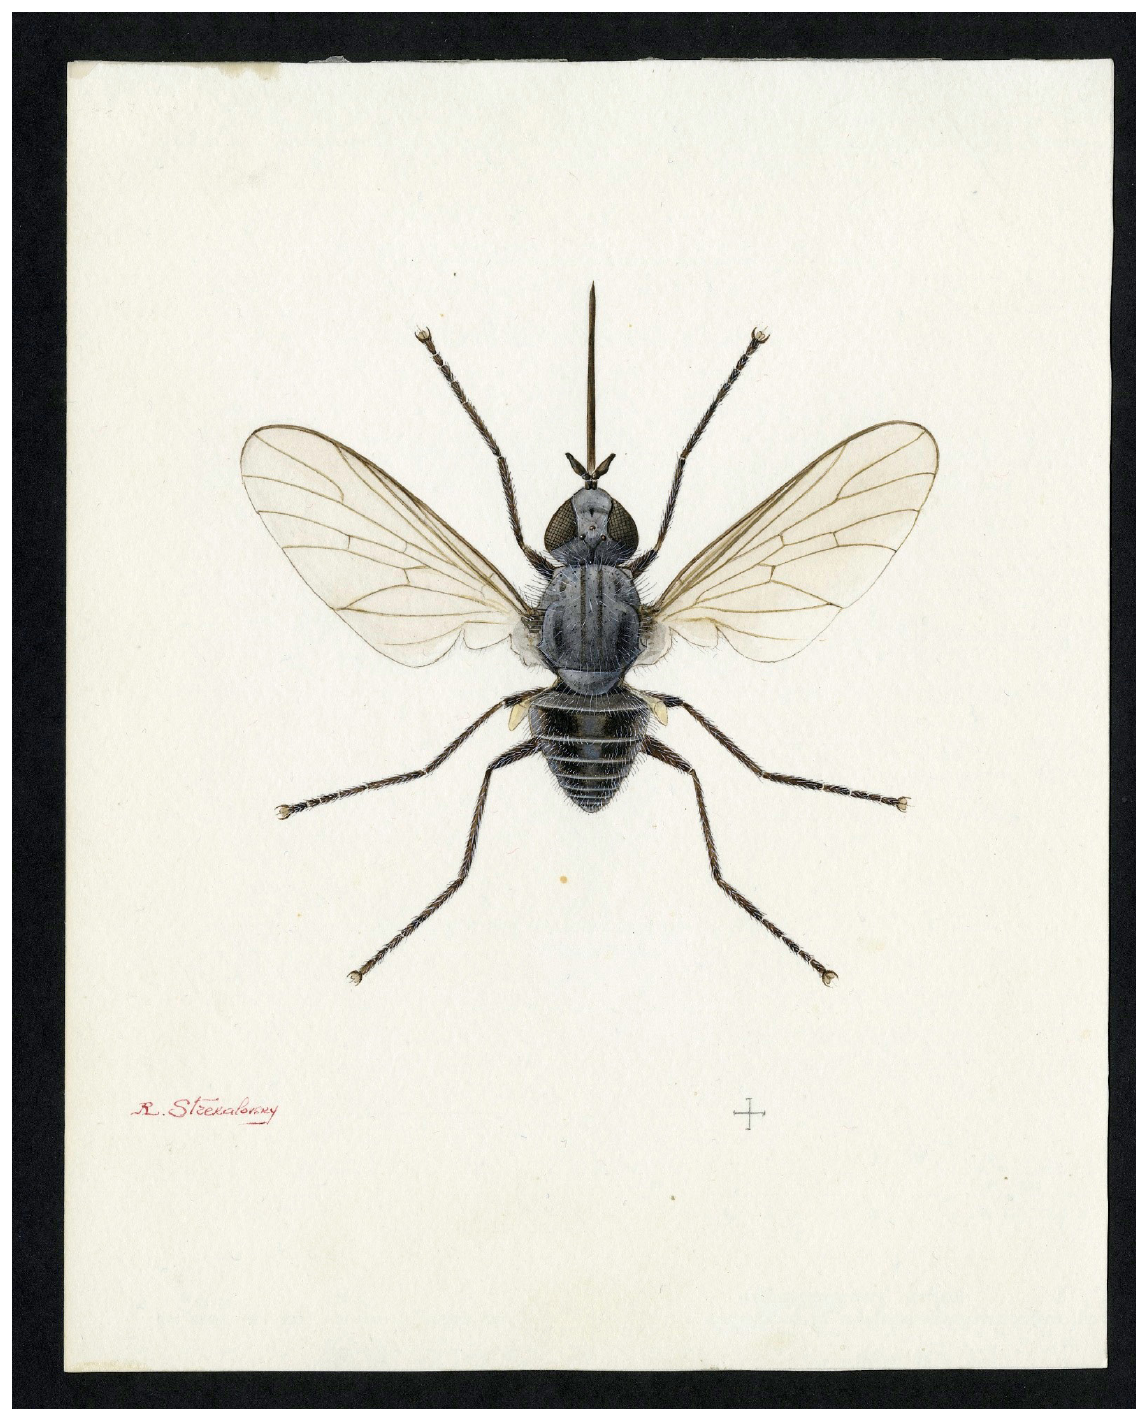
Fig. 57. Protypusia tewfiki (Efflatoun, 1945) gen. et comb. nov., habitus, Smithsonian Institution Archives. Image